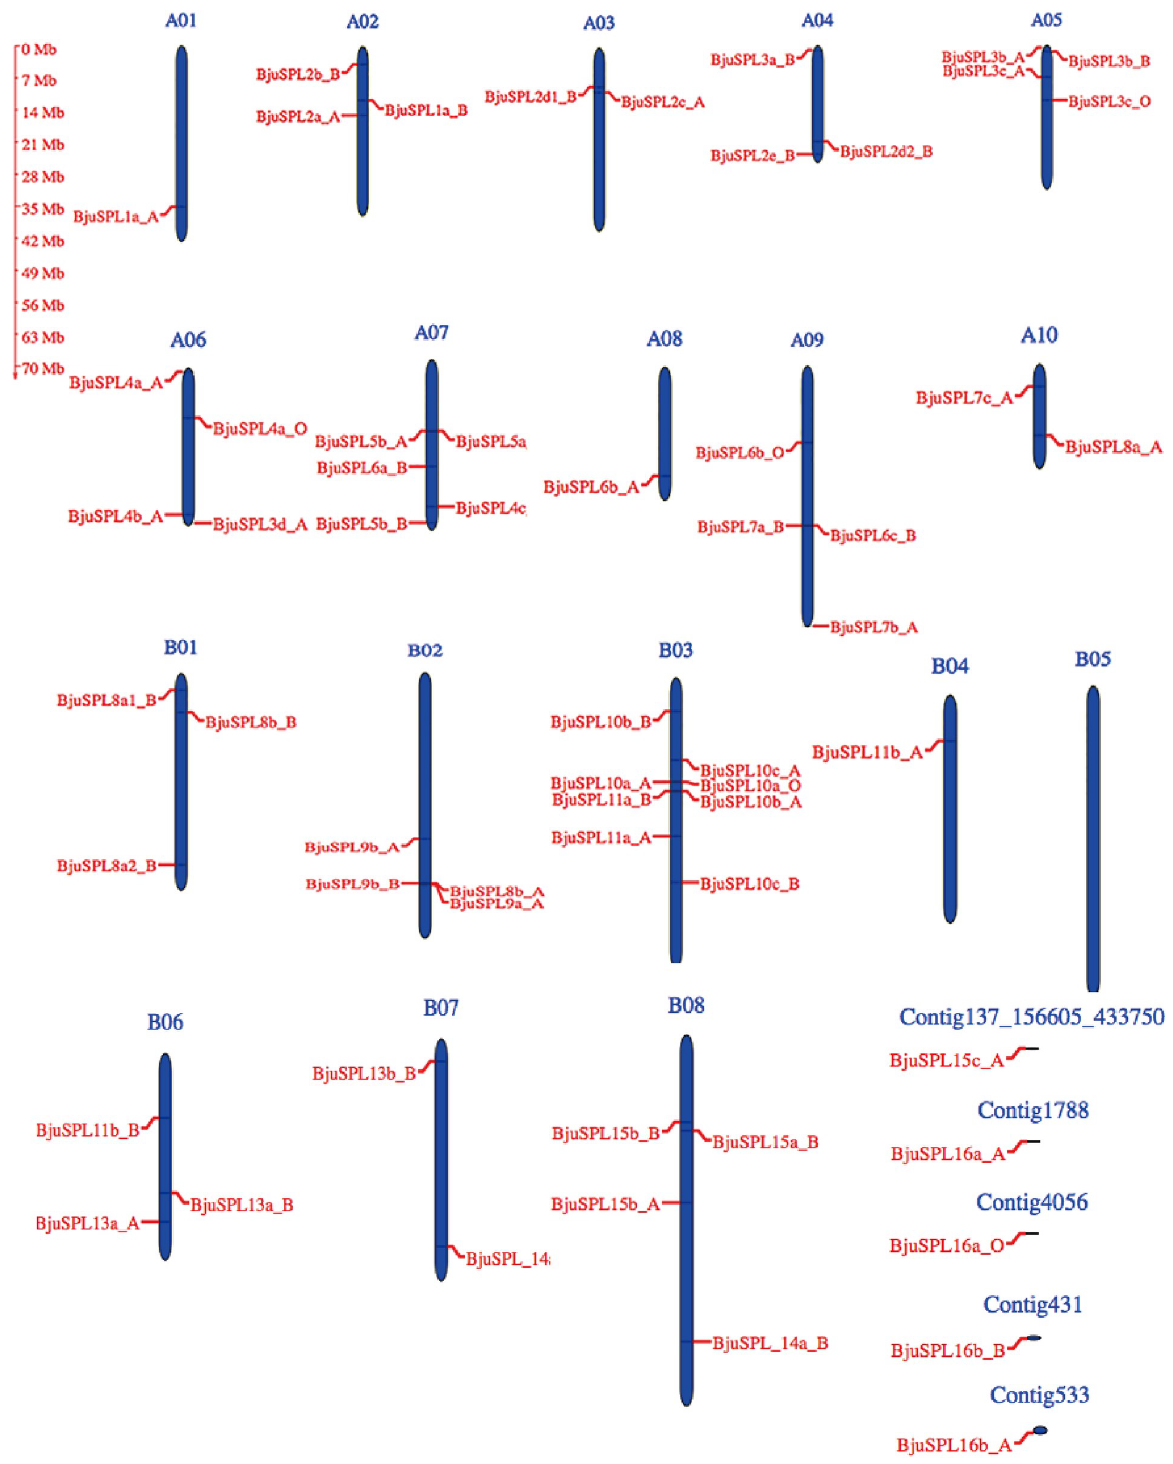
Fig 1. Distribution of SPL genes in the cruciferae genome. Chromosome distribution of SPL genes in B . juncea was identified, and the locations of closely linked genes were magnified. The chromosome number is indicated at the top of each chromosome. The scale is in megabases (Mb).